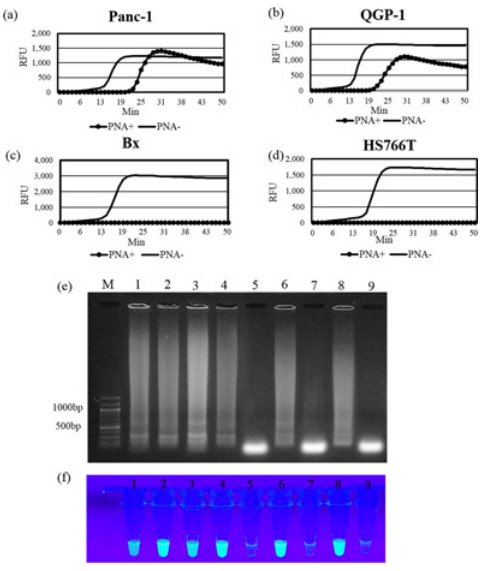
Fig 3. Amplification products of KRAS by PNA-LNA mediated LAMP. (a-d) The graphs indicate the fluorescence intensity of the LAMP products as measured using real-time PCR equipment. (e) The figure shows the detection by agarose gel electrophoresis. (f) The fluorescence emitted from LAMP products in microtubes under UV light was visually assessed. LNA primer complementary to the G12D mutant gene was used for Panc-1 and Bx cDNA samples, and the LNA primer complementary to the G12V mutant gene was used for QGP-1 and HS766T cDNA samples. M: size maker, lane 1 – 8: LAMP products from Panc-1 with PNA, Panc-1 without PNA, QGP-1 with PNA, QGP-1 without PNA, Bx with PNA, Bx without PNA, HS766T with PNA and HS766T without PNA, lane 9: negative control without cDNA.